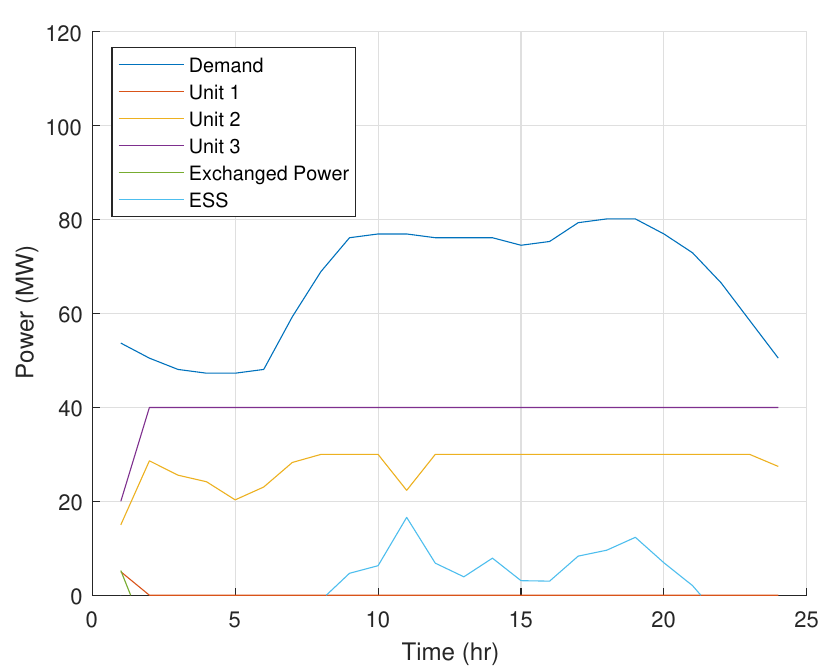
Figure 13. Economic dispatch with